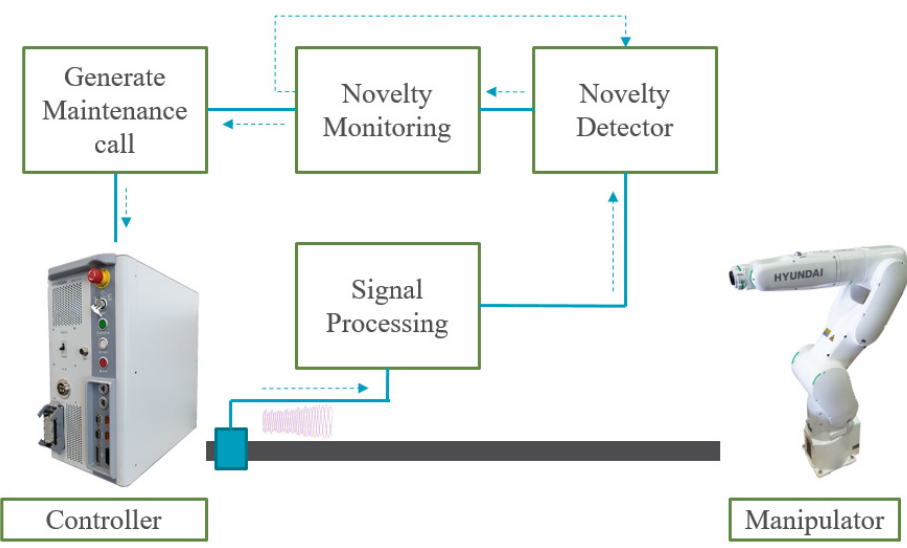
Figure 2. Overall structure of the proposed diagnosis system.